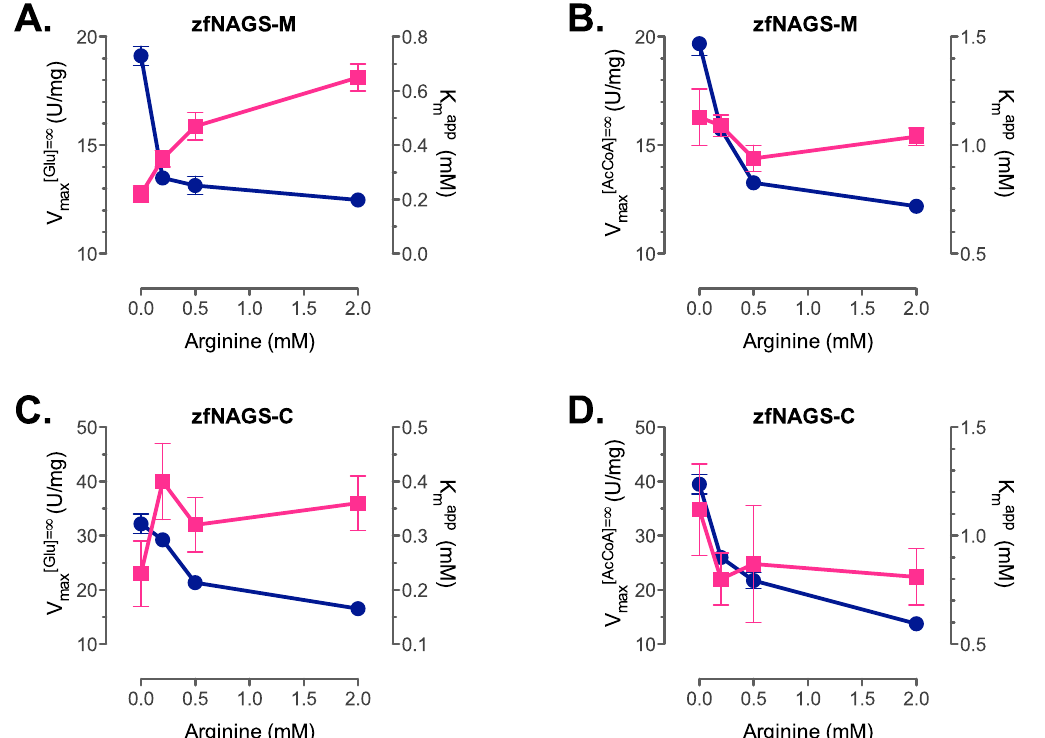
Figure 4. Effect of L-arginine on biochemical properties of zfNAGS-M and zfNAGS-C. K mapp and apparent V max for AcCoA (A and C) and glutamate (B and D) when increasing amounts of arginine were added to zfNAGS-M and zfNAGS–C. (Blue – V max ; Magenta – K mapp ). Error bars represent standard errors of the fitting parameters for the Michaelis-Menten equation. doi:10.1371/journal.pone.0085597.g004 of both proteins for AcCoA increased in the presence of L-arginine not exceed 0.65 mM. The intramitochondrial concentration of while the K mapp for glutamate did not change (Figure 4 and Table 1). Changes in both K mapp and apparent V max in the levels in mammalian mitochondria (0.12–1.34 mM [77,78]), the presence of L-arginine and binding of arginine to both zfNAGS-M and zfNAGS-C in the absence of substrates suggests a hyperbolic rate of NAG synthesis. The low K mapp for AcCoA and glutamate mode of inhibition; for both proteins the concentration of arginine that has half-maximal effect on the apparent V max and K mapp does and likely low level of inhibition of zebrafish NAGS by L-arginine